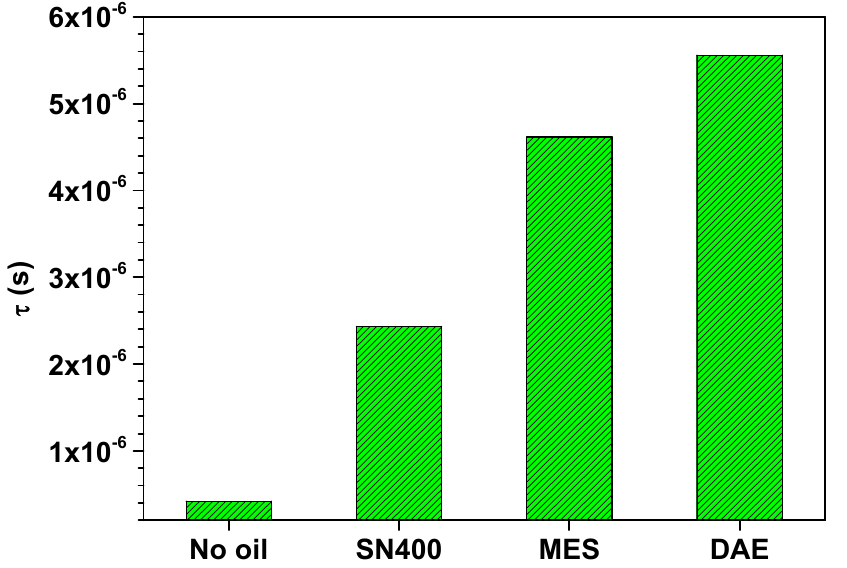
Figure 9. Cole–Cole relaxation time 𝜏 of the SBR samples determined by means of simultaneous mechanical and dielectric measurements at 24 °C under a static force of 10 N.